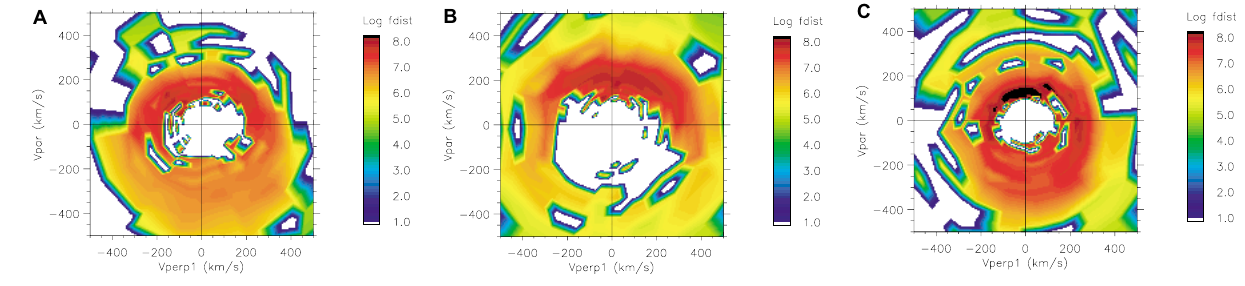
Fig. 7. Proton distribution functions from C4, showing shell-like features. (a) 02:54:59 UT, (b) 02:56:58 UT, (c) 03:09:58 UT. Shown is distribution function cuts in parallel and one perpendicular direction. Cuts of the distribution functions in perpendicular-perpendicular plane also display similar features (not